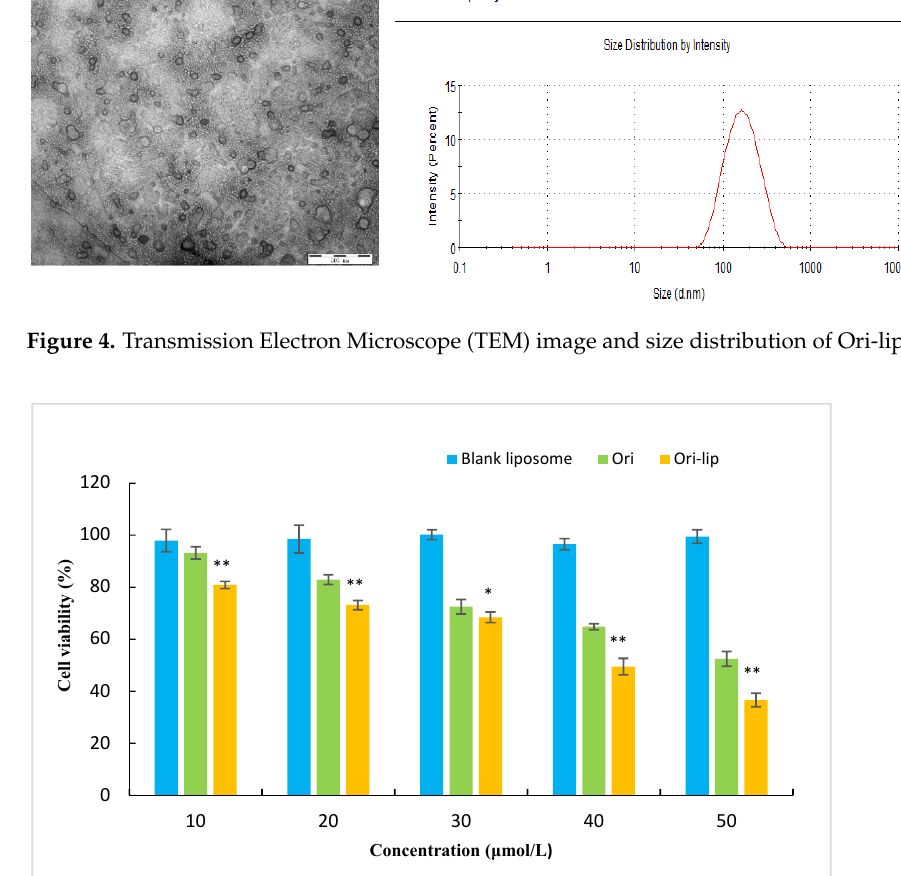
Figure 5. Cell survival curves after treating MCF-7cells with different concentrations of blank liposomes, free Ori, and Ori liposomes for 24 h. * p < 0.05, ** p < 0.01.